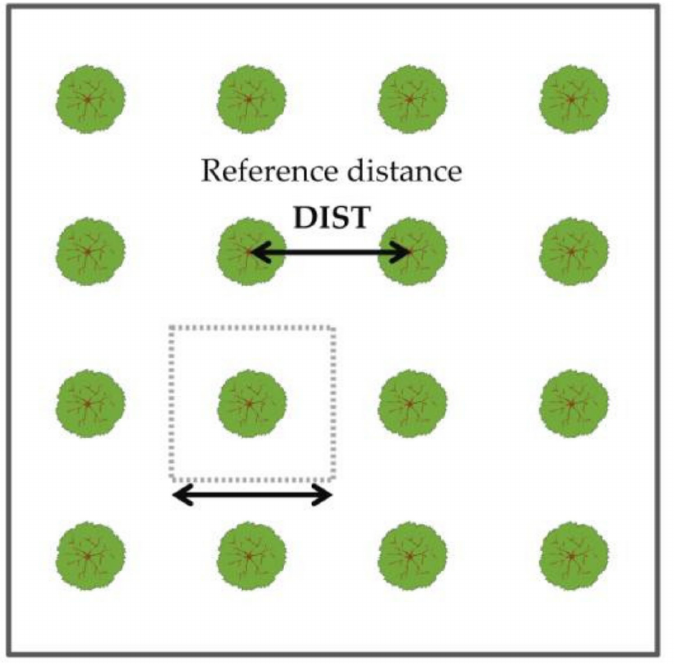
Figure 4. Stand geometry based on the mean distance between trees considering a squared